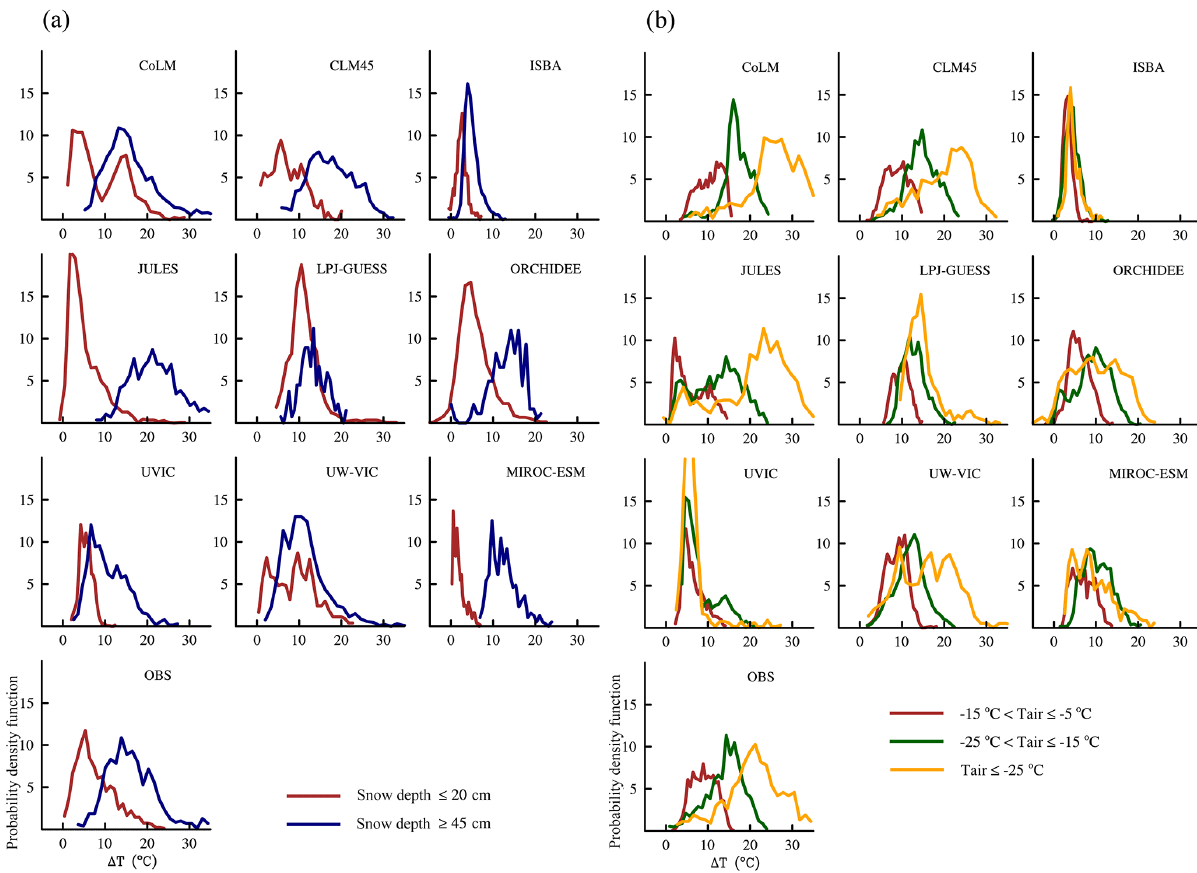
Figure 2. Conditional probability density functions (PDFs) of (cid:49)T ( ◦ C), the difference between soil temperature at 20cm depth and air temperature for (a) different snow depth classes and (b) air temperature regimes for winter 1980–2000.